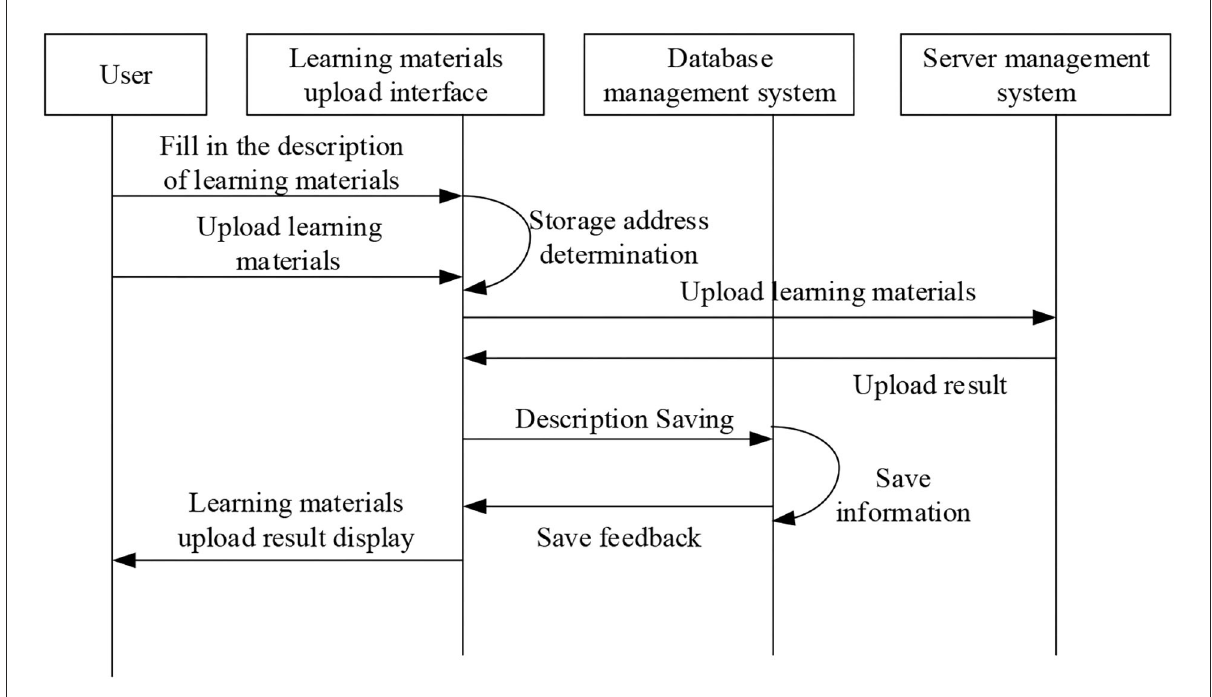
FIGURE8 Sequence diagram of micro-video course